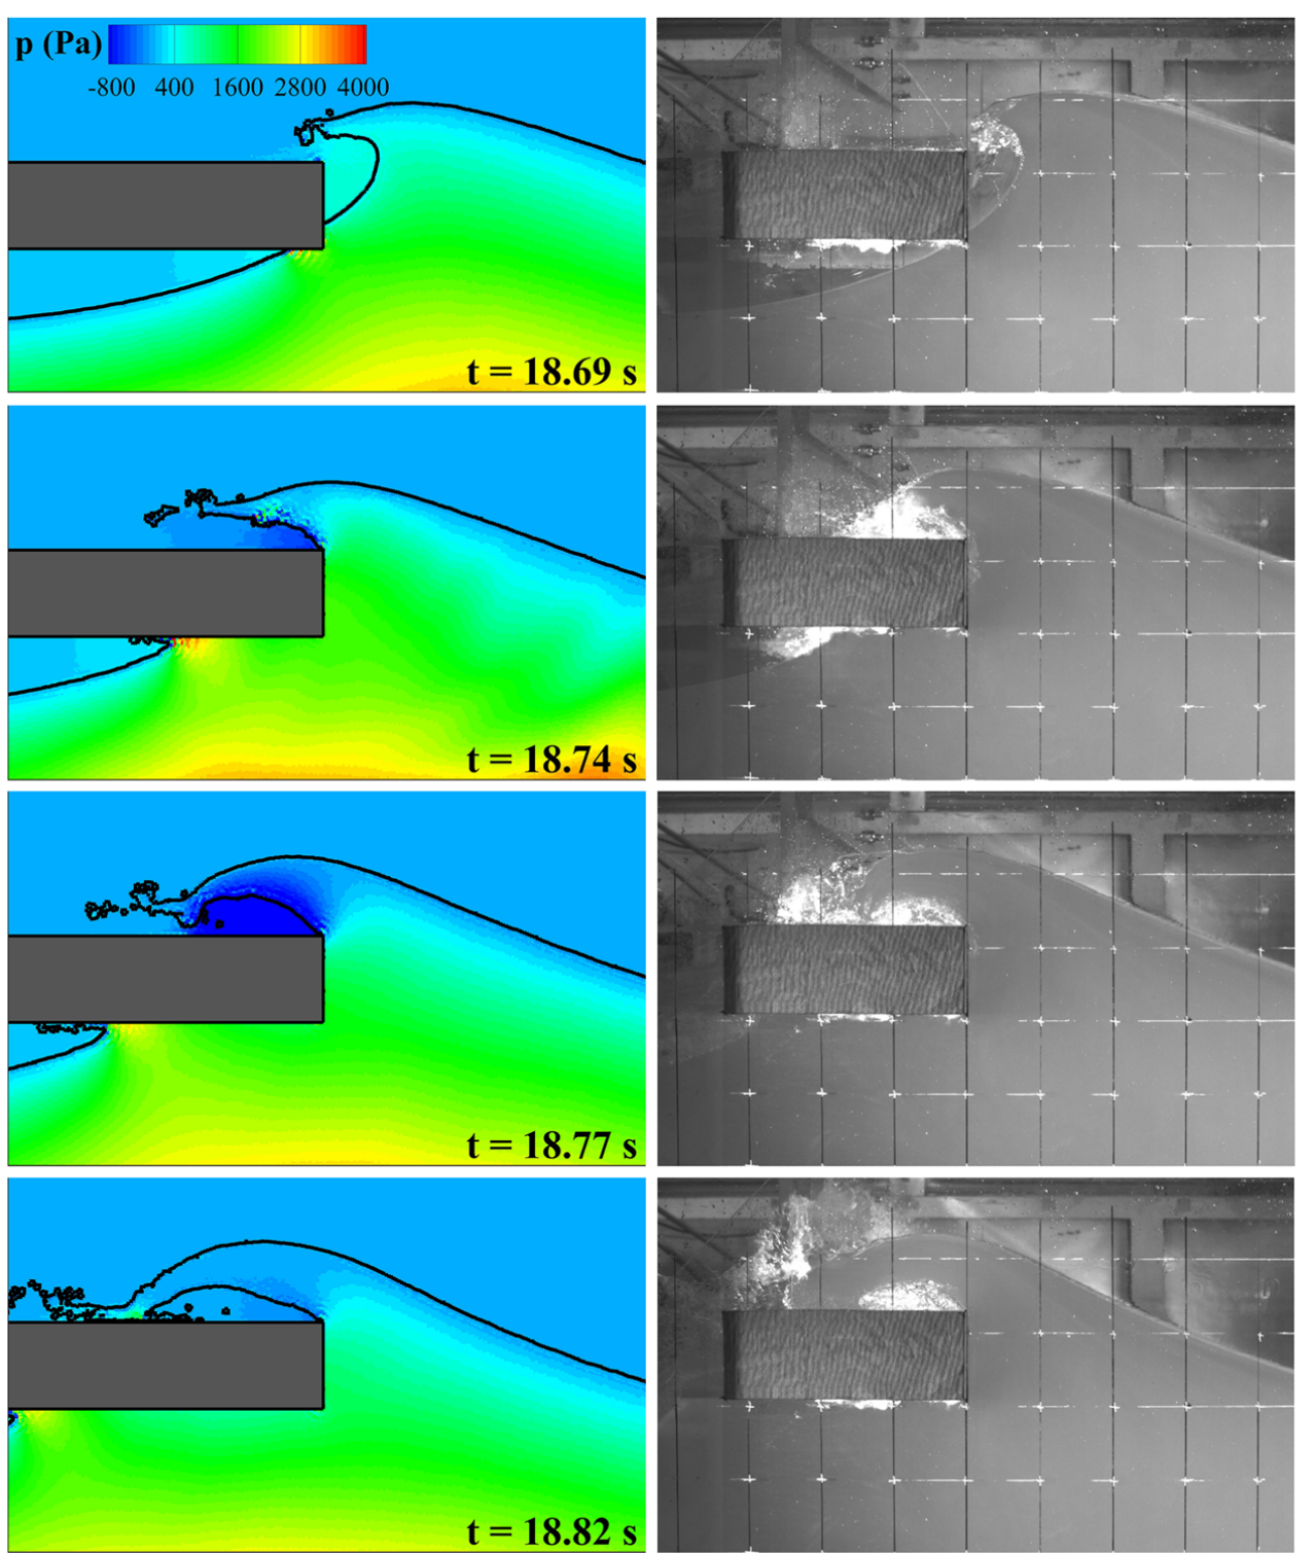
Figure 11. Comparison of δ + -SPH results (left) and experimental snapshots (right) for the freak wave impact problem